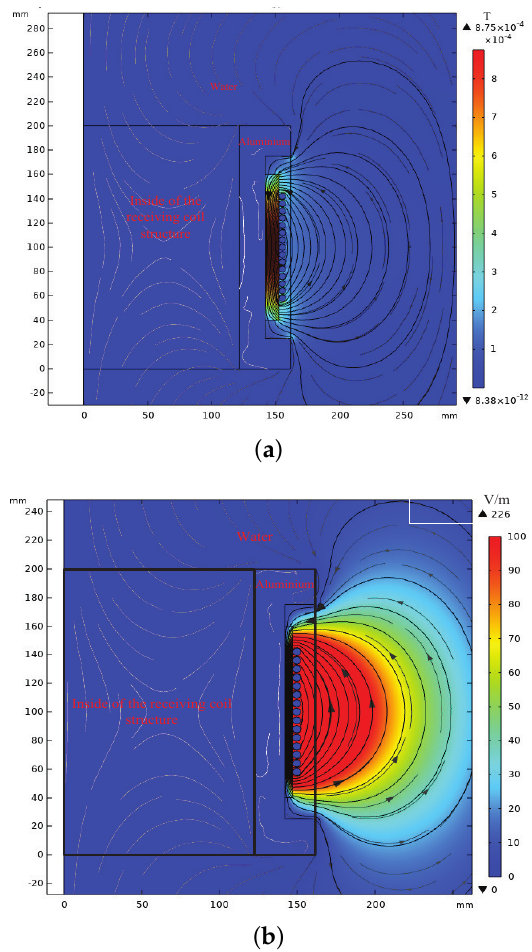
Figure 5. Electromagnetic field distribution of the receiving coil structure. ( a ) Magnetic field. ( b ) Elec- tric